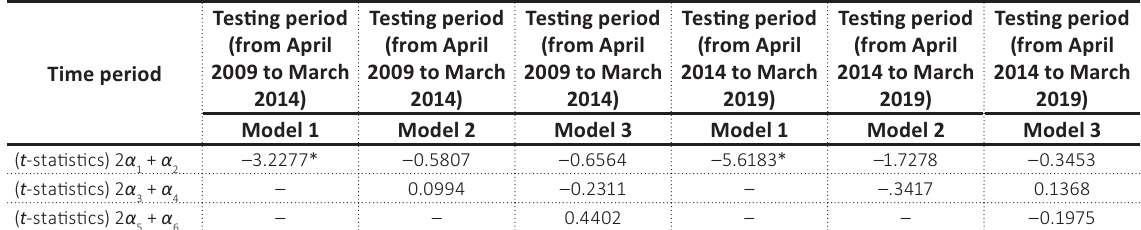
Table 5. Test for symmetry between co-moments and returns in up and down markets Time